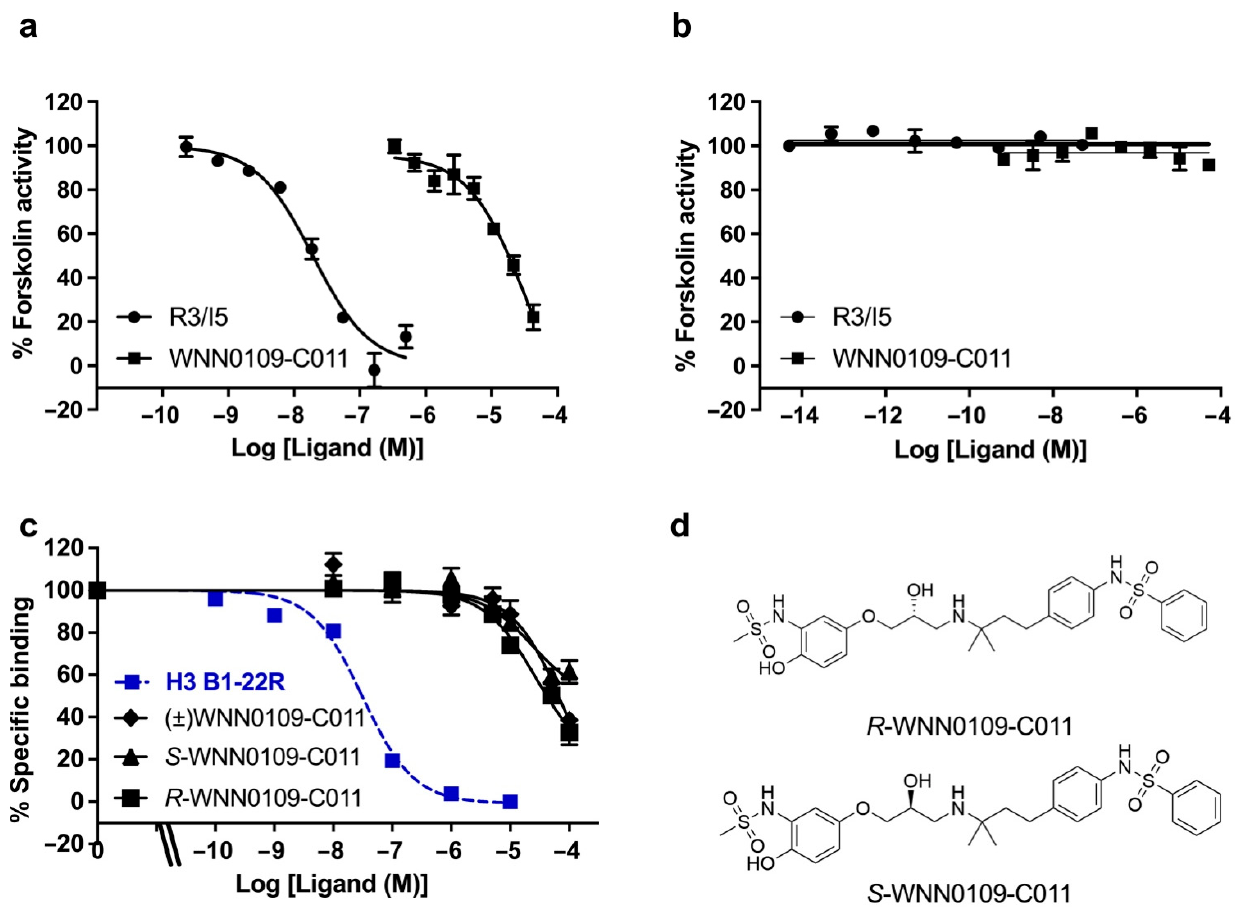
Figure 3. Specificity of WNN0109-C011. ( a ) WNN0109-C011 displayed an agonistic effect on hRXFP3-CHO cells. ( b ) WNN0109-C011 did not activate parental CHO cells. ( c ) Competitive binding of europium-labelled H3 B1-22R with WNN0109-C011 and its two enantiomers ( S -WNN0109-C011 and R -WNN0109-C011) in hRXFP3-CHO cells. ( d ) Chemical structures of the two enantiomers of WNN0109-C011. Data shown are means ± SEM.